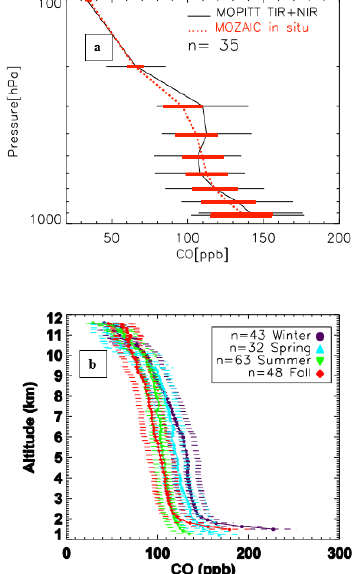
Figure 9. MOZAIC/IAGOS (AK) and the corresponding MOPITT CO profiles (a) and MOZAIC/IAGOS seasonal averages CO pro- file (b) . Horizontal bars are standard